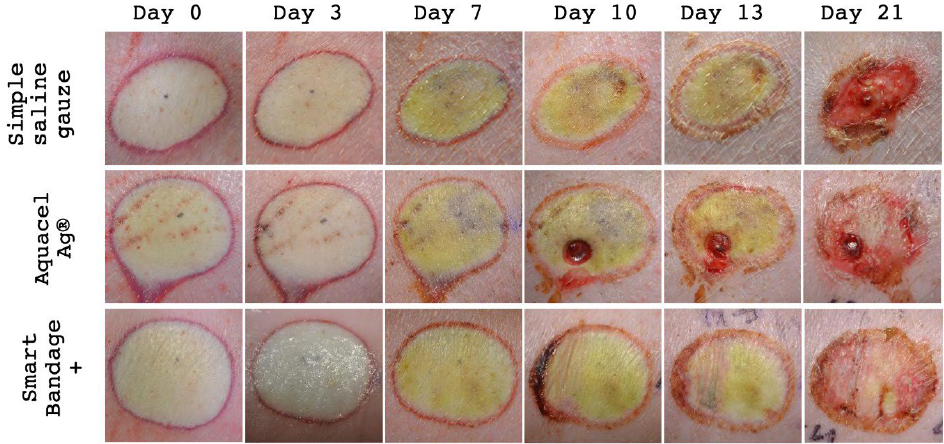
Figure 4. Representative burn wounds (out of total n = 18) treated with simple saline gauze, Aquacel Ag ® , Smart Bandage+ (INTELIGELS Ltd. Hoshaya, Israel) (with the addition of PHMB) over 21 days. Clinically, in both Aquacel Ag ® and Smart Bandage+ (INTELIGELS Ltd. Hoshaya, Israel) dressings, the healing processes were very similar on day 21 (punch biopsy was taken from Aquacel Ag ® on day seven after the photo was taken). However, on day ten, a semilunar crust developed on the left edge of the wound, treated with Smart Bandage+ (INTELIGELS Ltd. Hoshaya, Israel). This was related to the manual removal of the dressing material and did not appear on the other samples. In addition, the wound treated with simple saline gauze demonstrates delayed healing with remnants of deep burn areas at the center on day 21 and crusting on the inferior site.